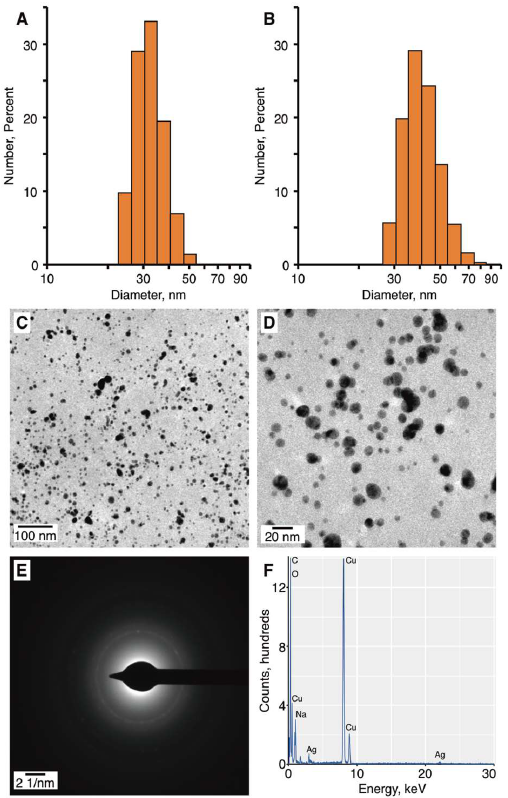
Figure 7. The morphology of silver nanoparticles (AgNPs) produced under optimal conditions. The histograms of size distribution by number of ( A ) purified AgNPs, and ( B ) non-purified AgNPs. ( C , D ) Representative transmission electron microscopy (TEM) micrographs of non-purified AgNPs, ( E ) the selected-area electron diffraction (SAED) pattern, and ( F ) the energy-dispersive X-ray spectroscopy (EDS) spectrum with prominent peaks